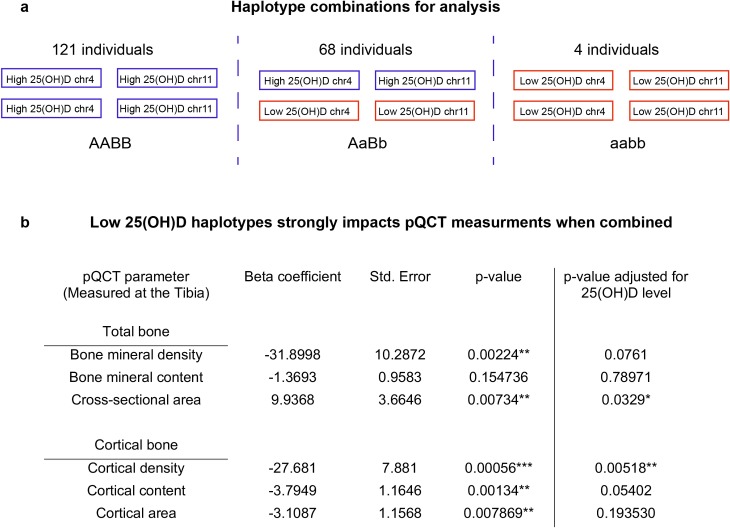
25(OH)D risk haplotypes affect skeletal parameters.a) The individuals are grouped based on haplotype combination (AABB, AaBb or aabb), just as in Fig 6, but here only the individuals with pQCT measurements at 24-months are shown (n = 193). b) When combined, the ‘low 25(OH)D’ haplotypes from the two loci are strongly associated to all pQCT-parameters except for bone mineral content (total bone). When adjusting for the 25(OH)D concentration the association disappears or weakens considerably, suggesting that vitamin D is the mediator of the effect. (** p<0.01; *** p<0.001).